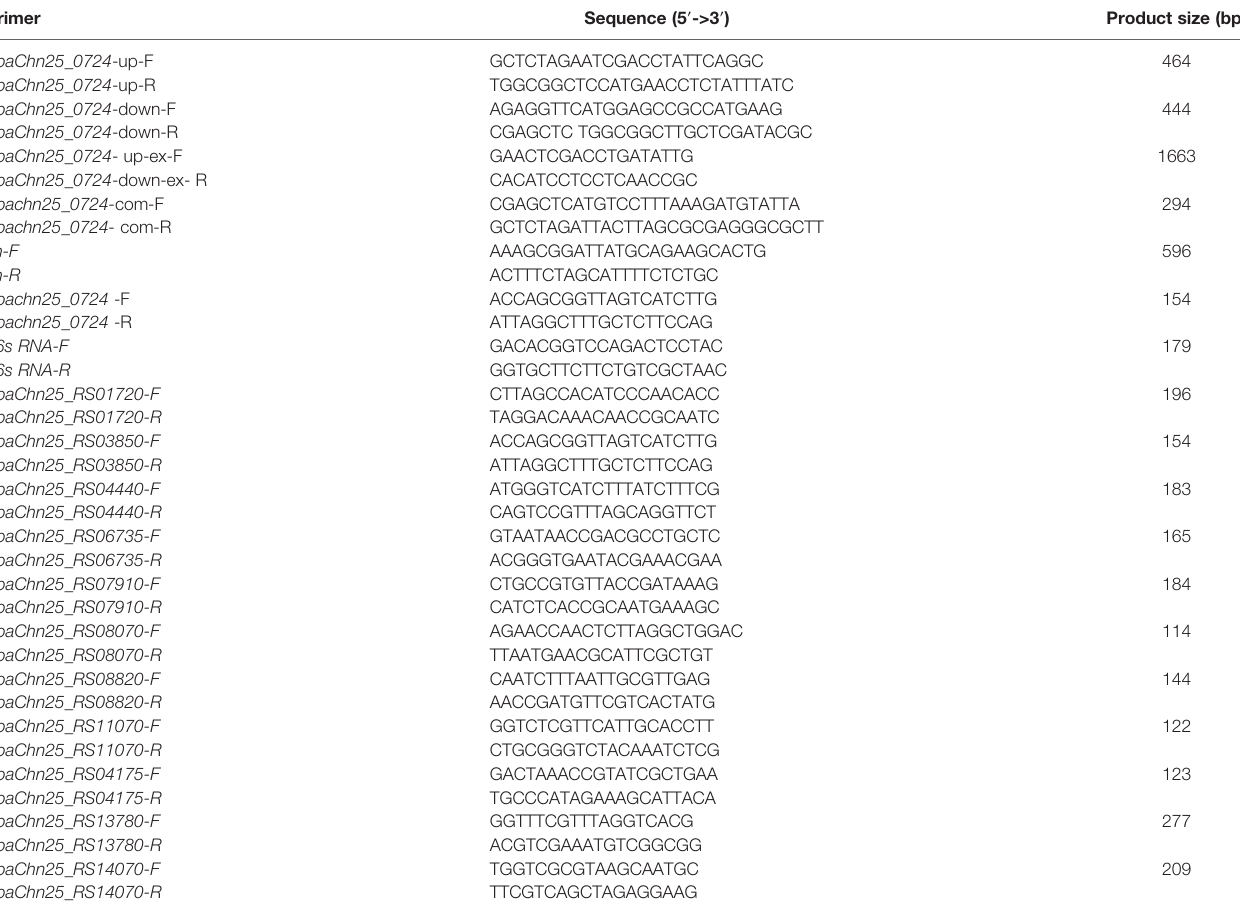
TABLE 1 | Oligonucleotide primers designed and used in this study.